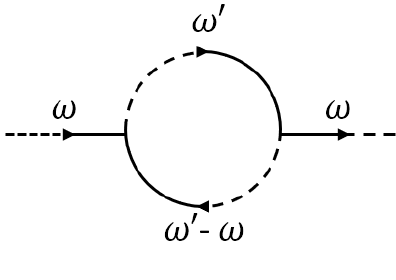
Figure 4 . One-loop contribution to the two-point function of x a